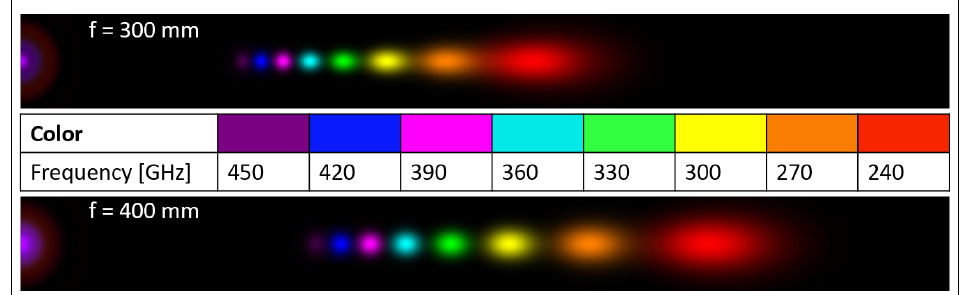
Figure 3. Calculated positions of the focal spots for structures with the focal lengths f = 300 mm ( top ) and f = 400 mm ( bottom ). Intensity distributions are shown with the main optical axis in the middle of left edge of the illustrated area. Colors denote the frequency of the illuminating radiation as in the